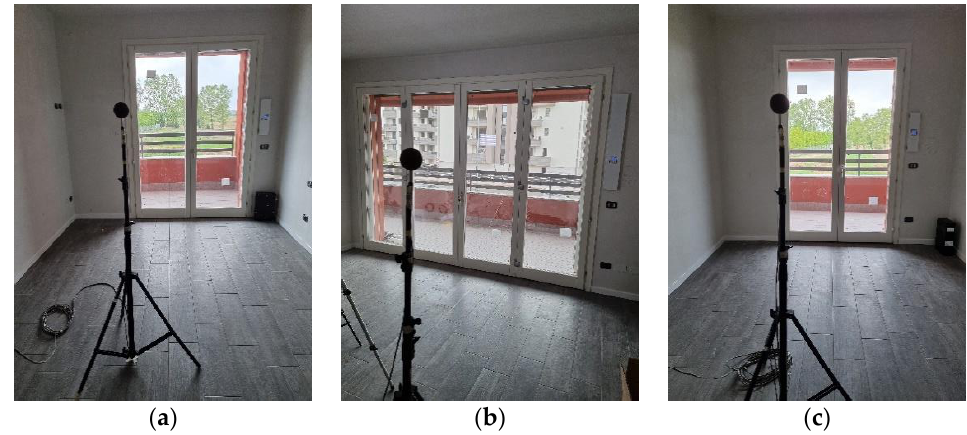
Figure 2. Sound pressure level measurements: ( a ) bedroom 1 with CM CMV, ( b ) living room with SM CMV and ( c ) bedroom 2 with CM CMV.